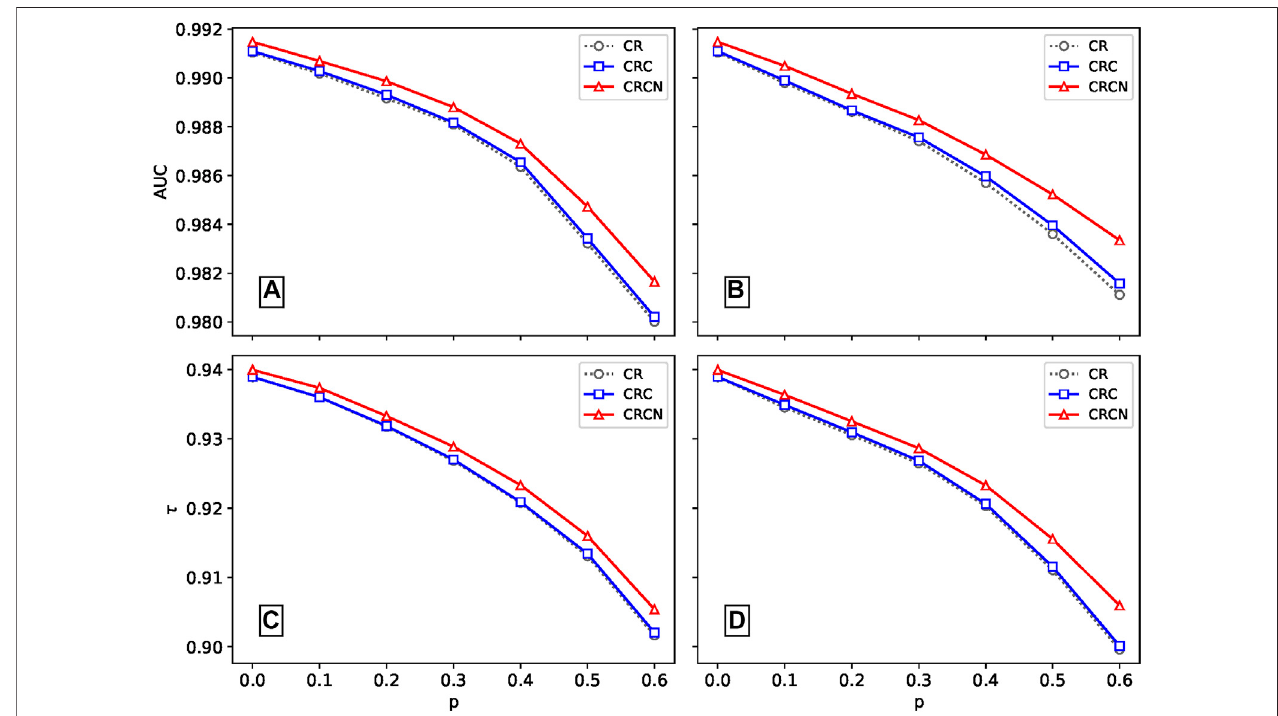
FIGURE 2 | Comparison of the robustness of the three algorithms. Panels (A) and (C) are the AUC and τ for different fractions p for random rating spamming, and panels (B) and (D) show the same for malicious rating spamming. The results are averaged over ten independent realizations.